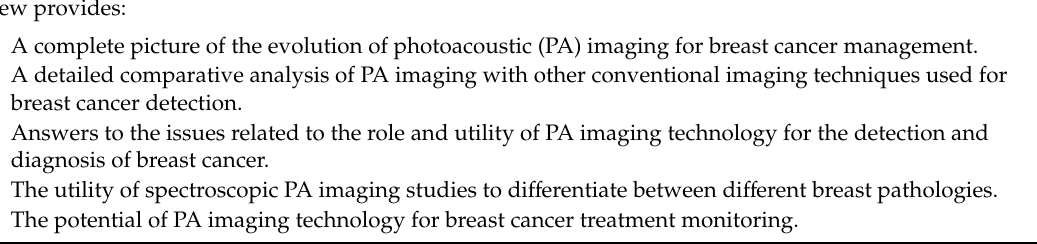
Table 1. Highlights of the presented